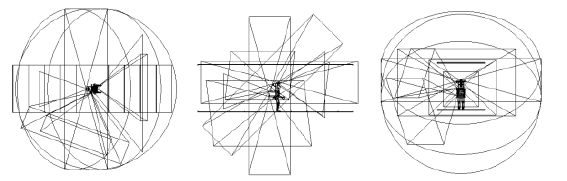
Figure 2. CAD simulation, including the sensors and their field of view; three views: top, side, back. As the cameras where placed on the backpack symmetrically, only one side is presented here, in order to improve the readability of the image During the planning phase, different configurations of the sensors where simulated in CAD software and we realized that the visibility conditions can be achieved, when the sensors are directed mostly to the back (opposite direction of the operator’s moving direction). After the general configuration was known, we refined the position and orientation of every sensor, so that the occlusions were minimal and the system was still small enough to be operational, particularly while passing through narrow passages and doors. Based on this conceptual design, the prototype was constructed (Fig. 3, right).